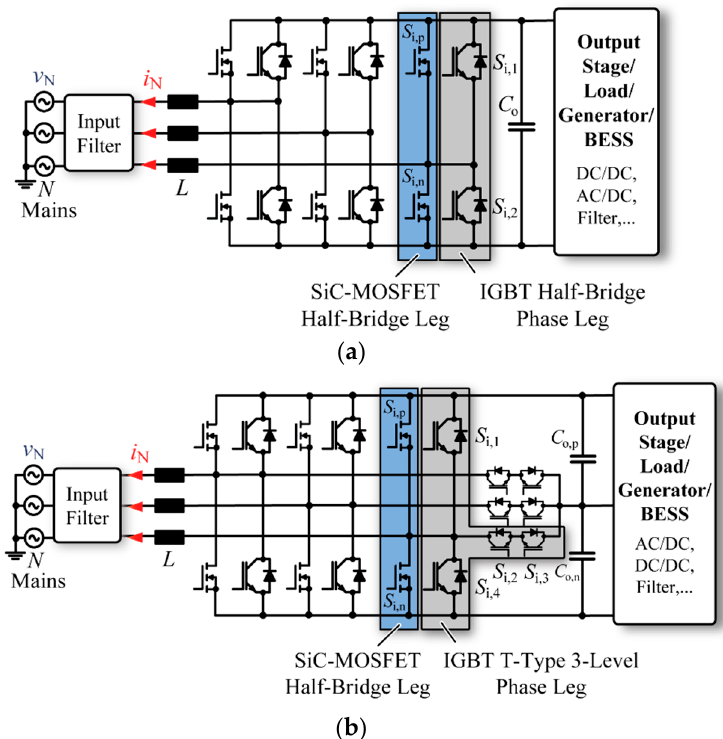
Figure 2. Three-phase grid-connected ( a ) 6-switch or ( b ) t-type IGBT-based rectifier/inverter with equipped 3 different SiC half-bridge legs for each converter input phase.